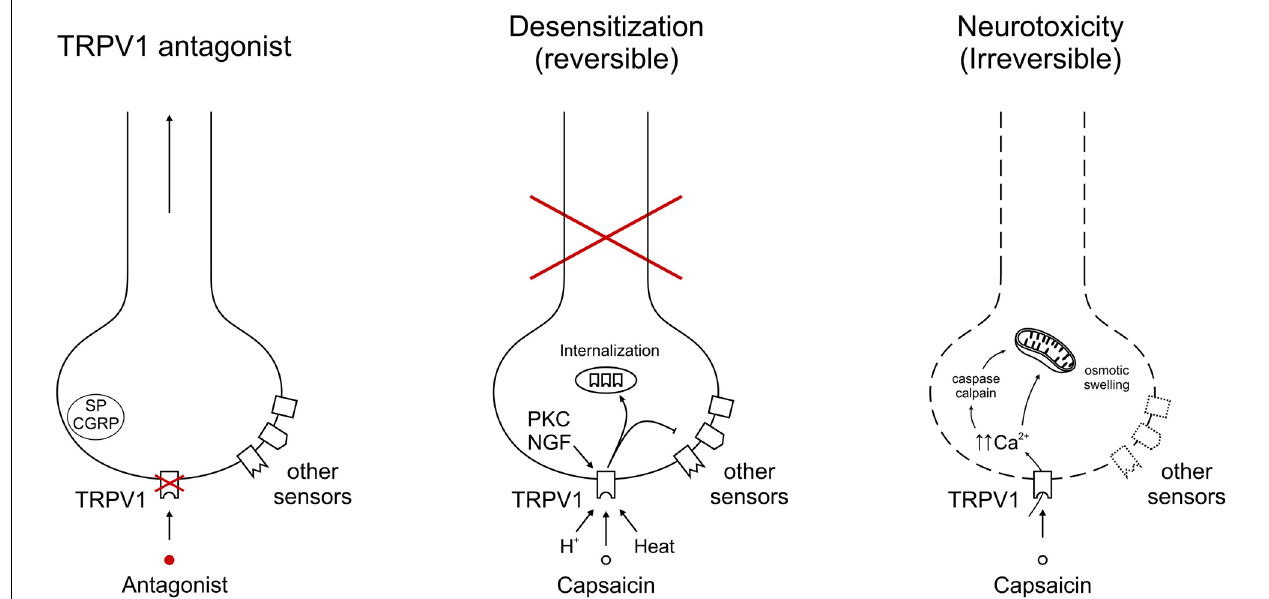
FIGURE 1 | Representative depiction of TRPV1 modulation on afferent nerve endings. (Left) Specific TRPV1 antagonism blocks TRPV1-mediated signals, but allows transduction of the neuron through other sensors. Neuropeptides Substance P (SP) and calcitonin gene-related peptide (CGRP) indicate the potential to contribute to neurogenic inflammation. (Middle) Sustained and/or repeated TRPV1 gating leads to internalization of the receptor into intracellular stores, from which it is recycled or broken down. With capsaicin, heat or protons, exemplary TRPV1 agonists are depicted, in addition acute sensitization by PKC and longer-term expression regulation by NGF. The inhibitory arrow to other sensors indicates cross-desensitization of other sensors leading to a reversible inactivation of this neuron. (Right) TRPV1 activation leading to unsustainable intracellular calcium concentrations gives rise to irreversible damage. Mechanisms include cellular stress, e.g., through calcium, caspase and calpain